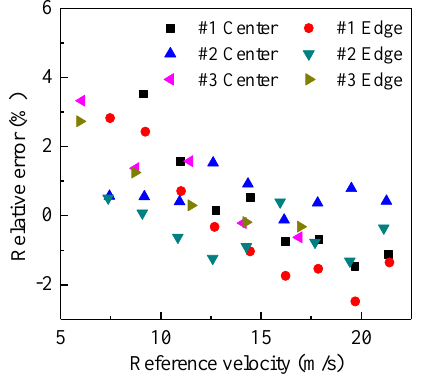
Figure 10. Relative measurement error of velocity.